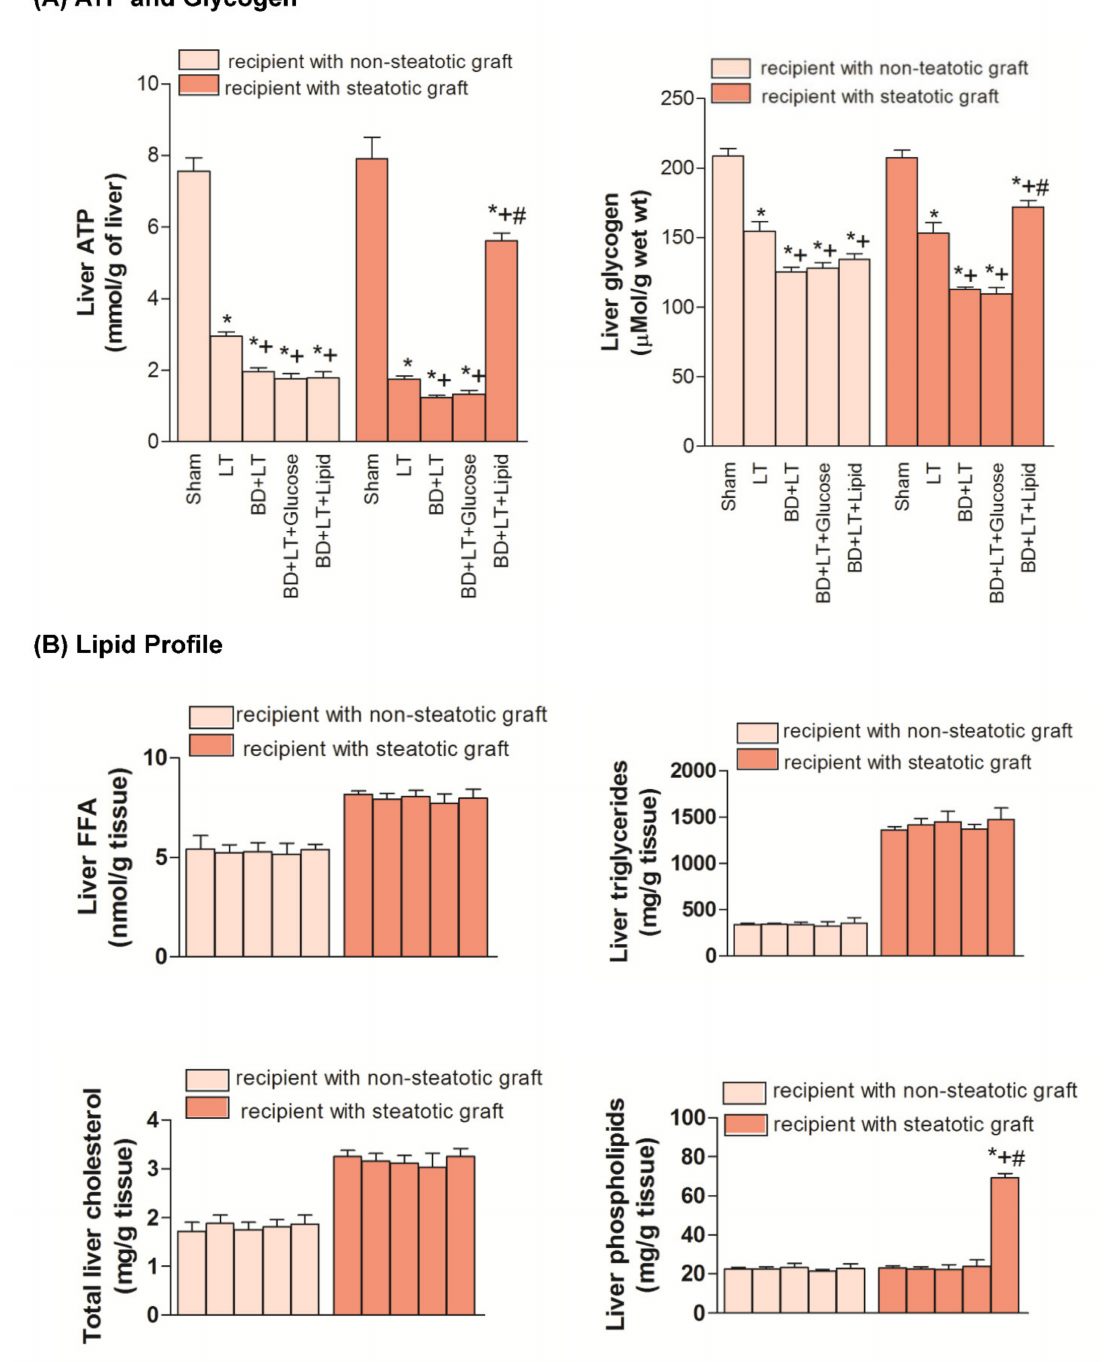
Figure 6. Effects of glucose and lipids on ATP, glycogen and lipid profile in steatotic and non-steatotic LT in a nutritional obesity model. ( A ) Adenosine triphosphate (ATP) and glycogen content in liver. ( B ) Free fatty acids (FFA), triglycerides, total cholesterol and phospholipids in liver. * p < 0.05 vs. Sham. + p < 0.05 vs. Liver Transplantation (LT). # p < 0.05 vs. Brain Death+Liver Transplantation (BD + LT). DBD, Donors after Brain